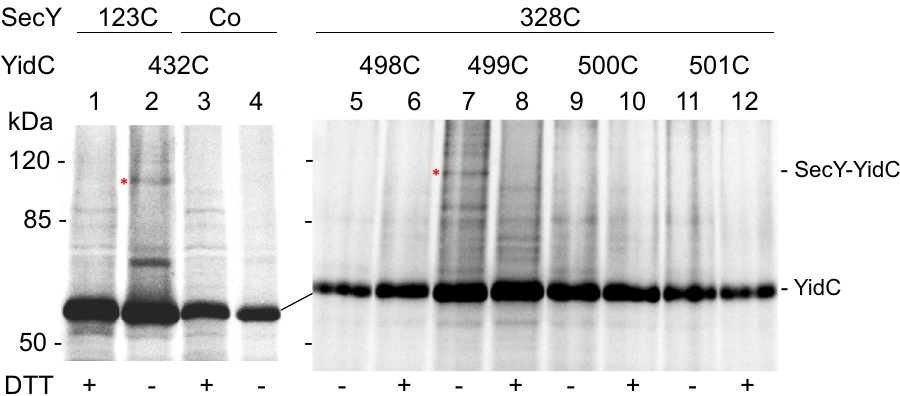
Figure 5. YidC and SecY show cross-links between the hydrophobic slide and the lateral gate. Single cysteine mutants of YidC and SecY were generated and co-expressed in E. coli MK6. YidC432C was coexpressed with SecYEG that had a single cysteine at position 123 in TM3 of SecY (lanes 1, 2). The cells were pulse-labelled with 35 S-methionine and treated with 200 µM DTNB (all lanes) followed by 1 mM DTT (lanes 1, 3, 6, 8, 10, 12) in some cases and analysed by immunoprecipitation with an antiserum to YidC and phosphorimaging. For a control, SecYC 0 was coexpressed with YidC432C (lanes 3, 4). SecY that has a single cysteine at residue 328 in TM8 was coexpressed with the YidC mutants that have a single cysteine either at 498, 499, 500 or 501 in TM5. A cross-link band was observed between SecY328C and YidC499C (red asterisk). The expression of SecY was monitored on a Western blot (Fig. S7).